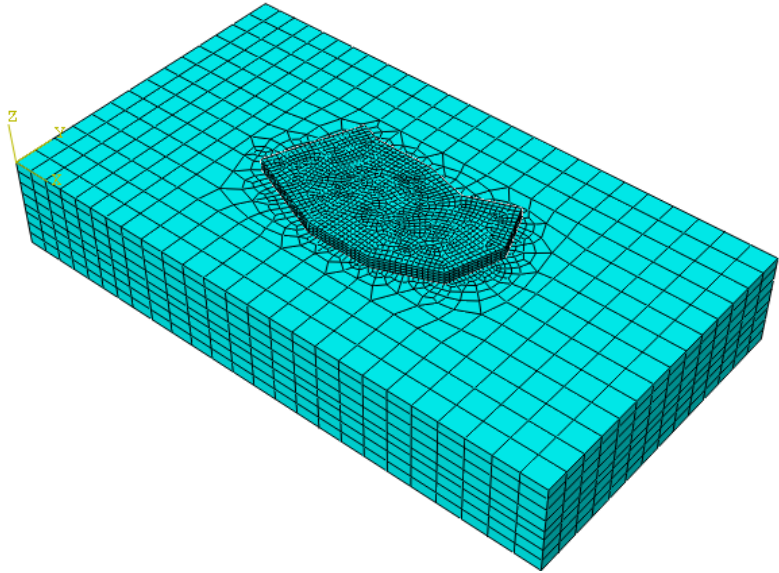
Figure 5. Typical finite element mesh.